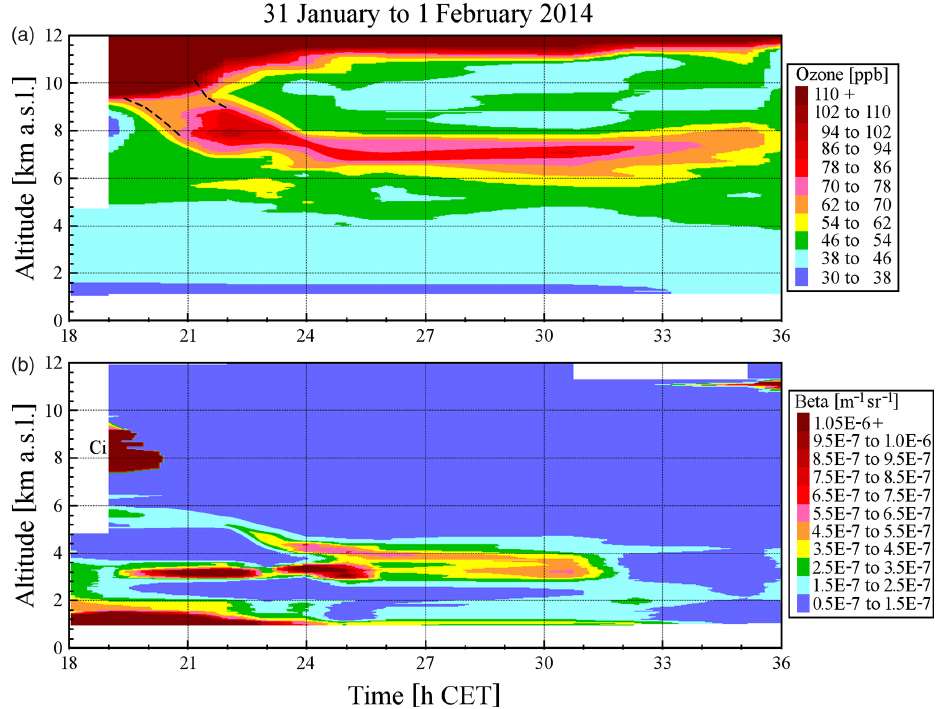
Figure 5. Time series of ozone (a) and the 313nm aerosol backscatter coefficient (b) on 31 January and 1 February 2014: Both a stratospheric intrusion layer (6.5–9km) and a weak to moderate Saharan dust event 2.5–6km are seen. Due to a 3h data gap between 19:00 and 22:00CET the colour coding during this period is highly uncertain. The intrusion could also have formed a full tropopause fold as indicated by the dashed black